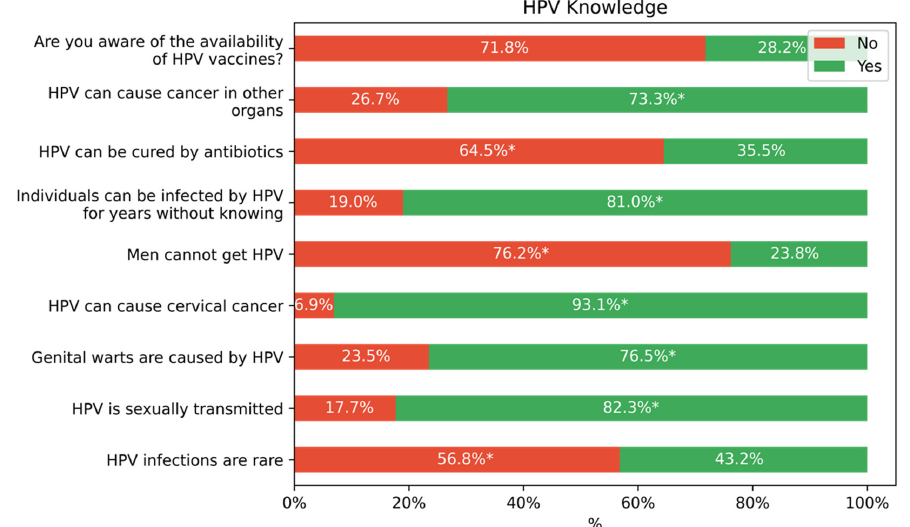
Figure 2. The distribution of responses to the questions evaluating HPV knowledge. * indicates correct responses.